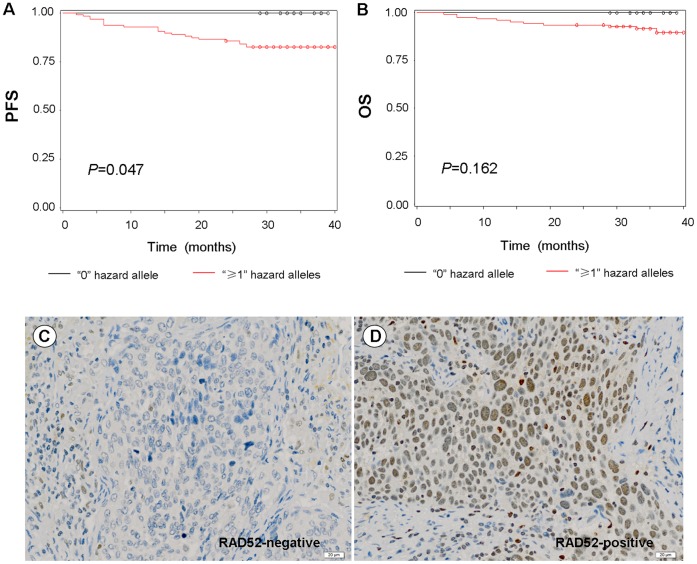

Kaplan-Meier survival estimates (A) progression-free survival and (B) overall survival by combined genotypes of the three selected RAD52 SNPs.The patients carrying at least one (≥1) variant allele (i.e., rs10774474T, rs11571378A and rs1051669A) had poorer progression-free survival and overall survival compared to those without any of the variant alleles (log-rank test, P = 0.047 and 0.162, respectively). RAD52 (C) negative and (D) positive expression with low cytoplasmic background was detected by antibody sc-8350 (400×).